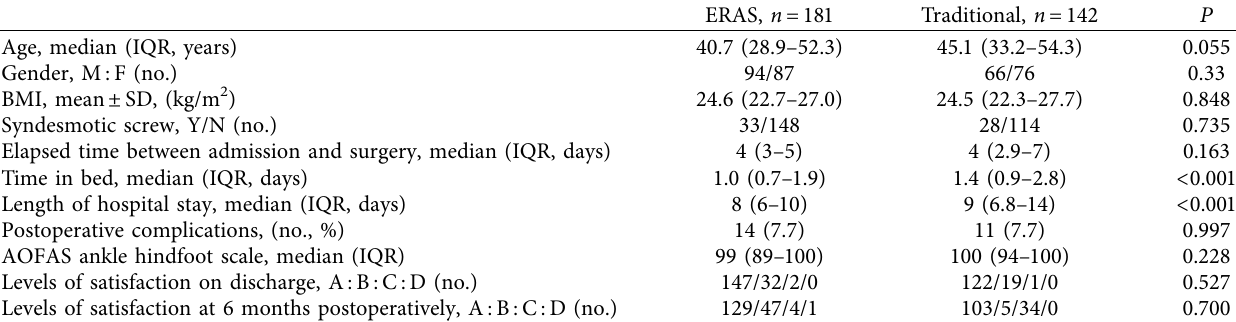
Table 7: Subgroup analysis among patients with ankle